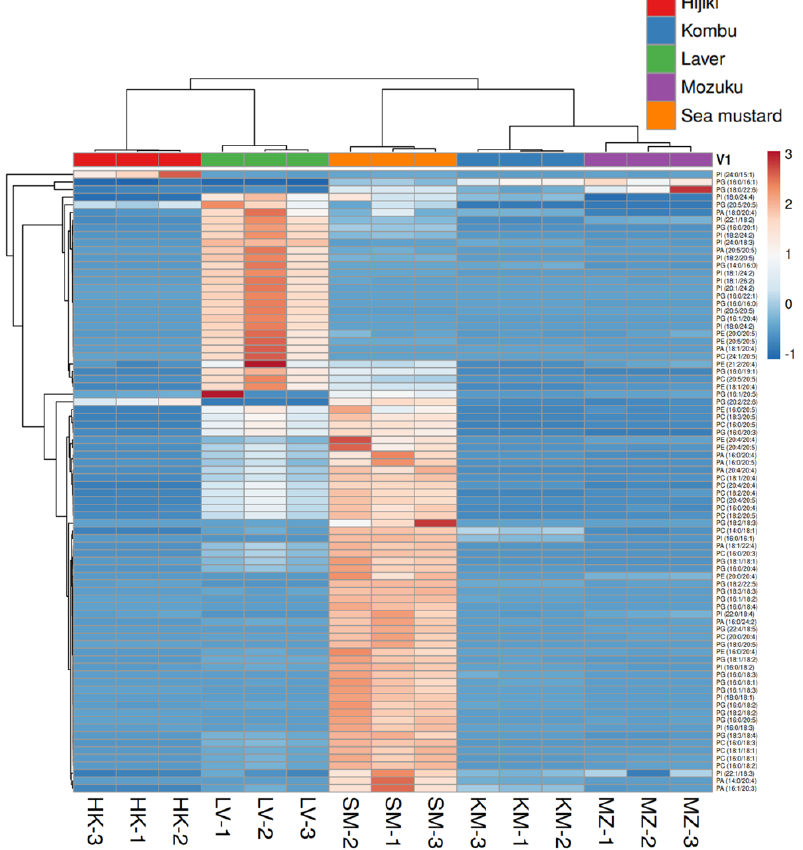
Figure 6. Hierarchical cluster correlation heatmap of glycerophospholipids. Phosphatidic acid (PA), phosphatidylglycerol (PG), phosphatidylcholine (PC), phosphatidylethanolamine (PE), and phosphatidylinositol (PI). HK: Hijiki, KM: Kombu, LV: Laver, MZ: Mozuku, SM: Sea mustard.